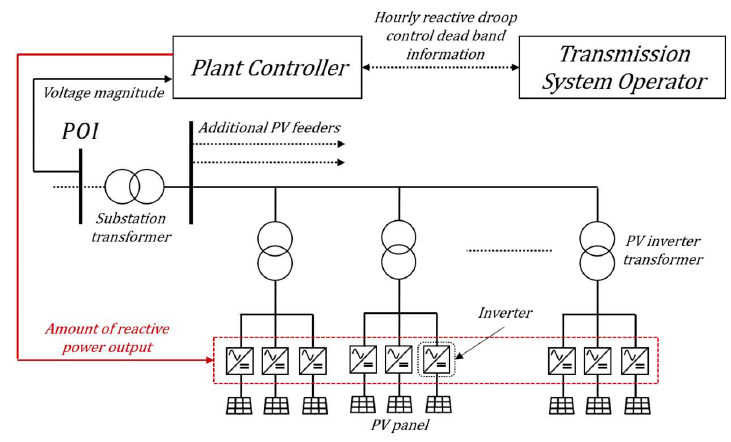
Appl. Sci. 2020 , 10 , x FOR PEER REVIEW Figure 2. Simplified diagram of the proposed scheme. Figure 2. Simplified diagram of the proposed scheme.